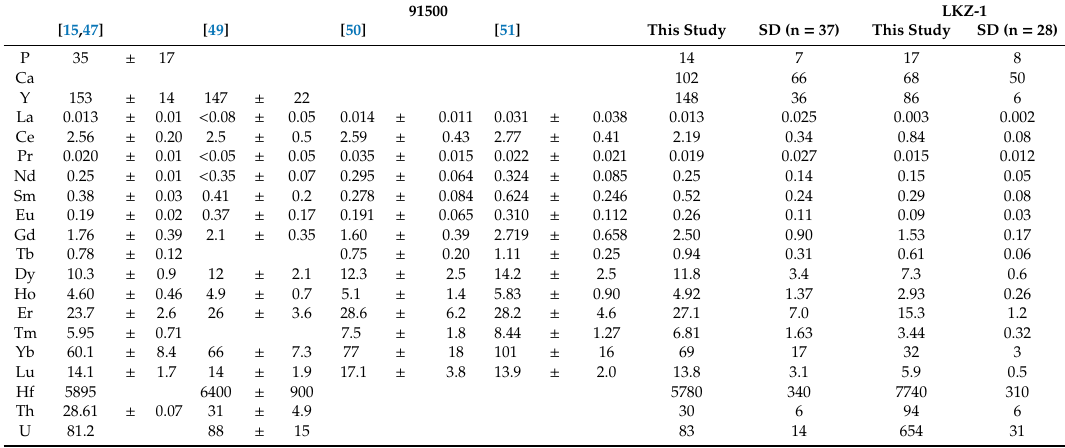
Figure 6. Hafnium isotopic variation in the LKZ-1 zircon. Vertical error bars denote 2 standard errors. Solid and dashed lines represent the average (0.281794) and standard deviation ( ± 0.000016), respectively. Table 7. Summary of chemical data for the 91500 and LKZ-1 zircons (unit: ppm).